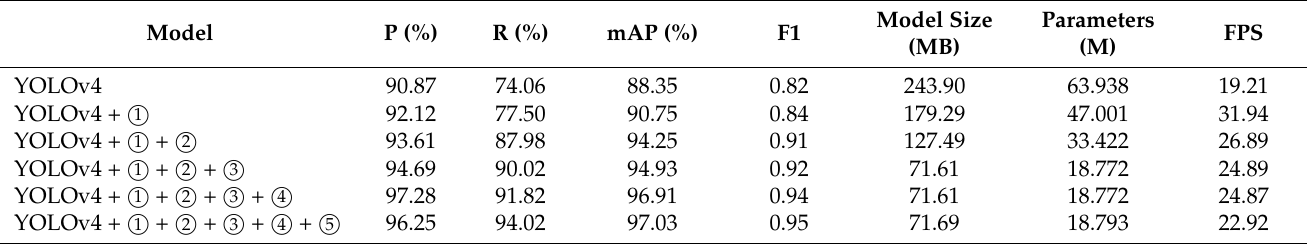
Table 3. Comparison of detection results of different improved